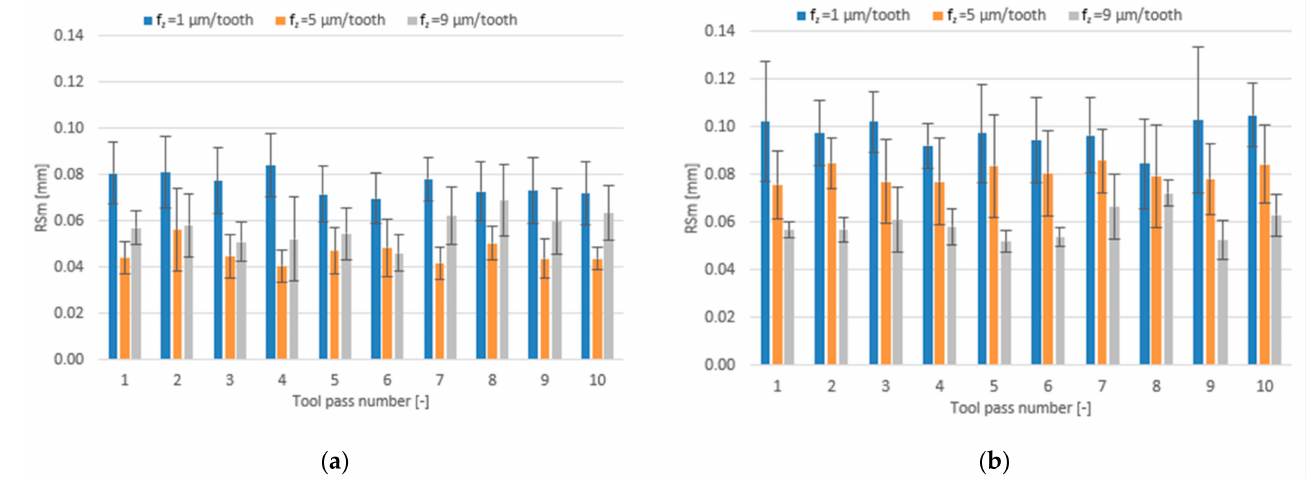
Figure 14. Feed per tooth f z versus surface roughness parameter RSm in the milling process performed using a tool coated with: ( a ) TiB 2 and ( b ) TiAlN; (v c = 800 m/min; a p = 80 µ